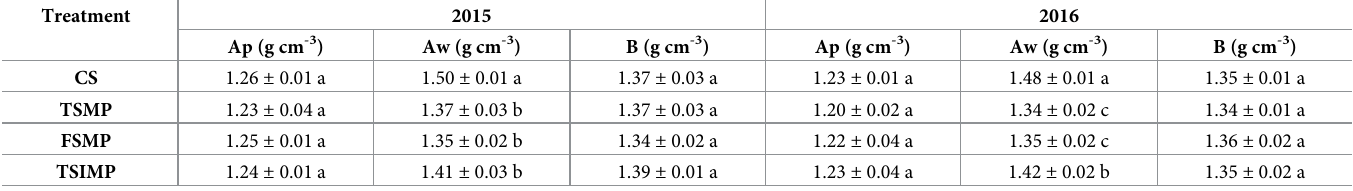
Table 1. Effects of soil mixing on the bulk density of Albic soil.